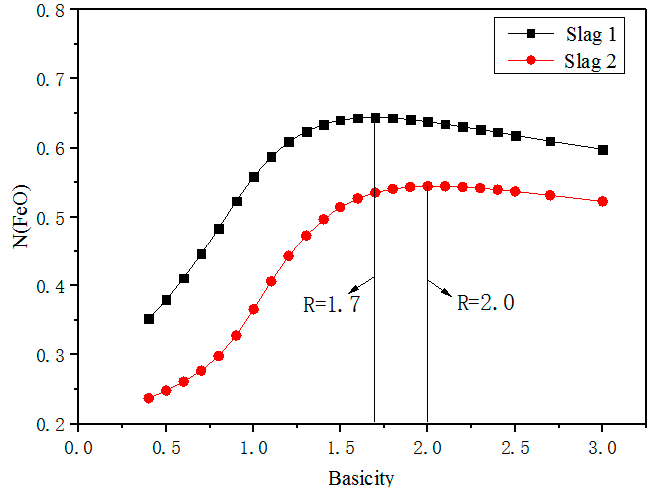
Figure 4. Effect of basicity on N FeO .